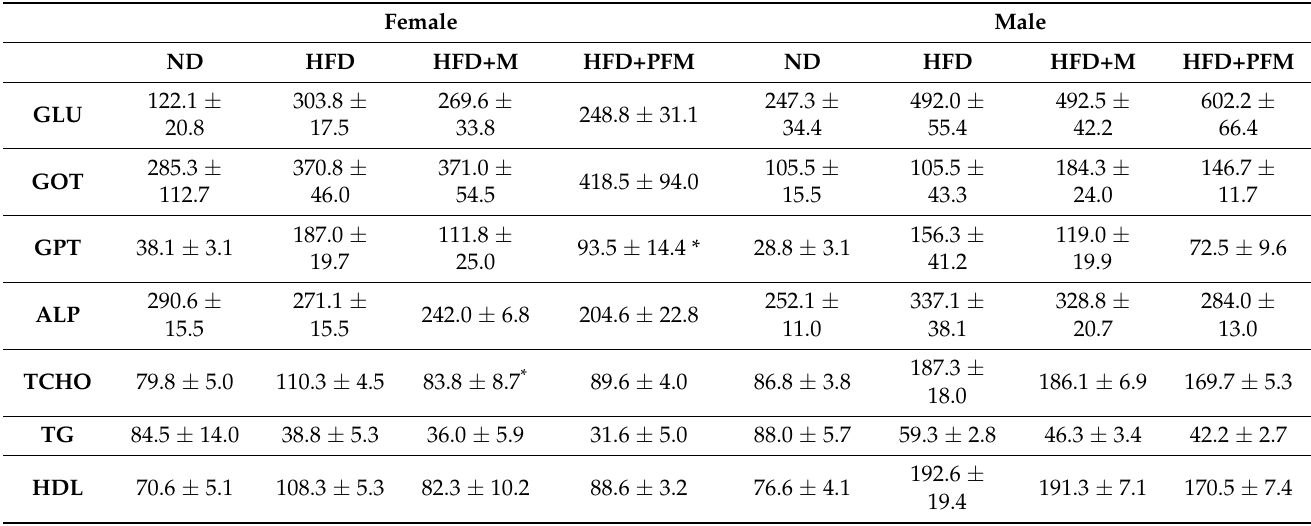
Table 4. Effects of miso or PFM on serum levels of GLU, GOT, GPT, ALP, TCHO, TG and HDL. Female